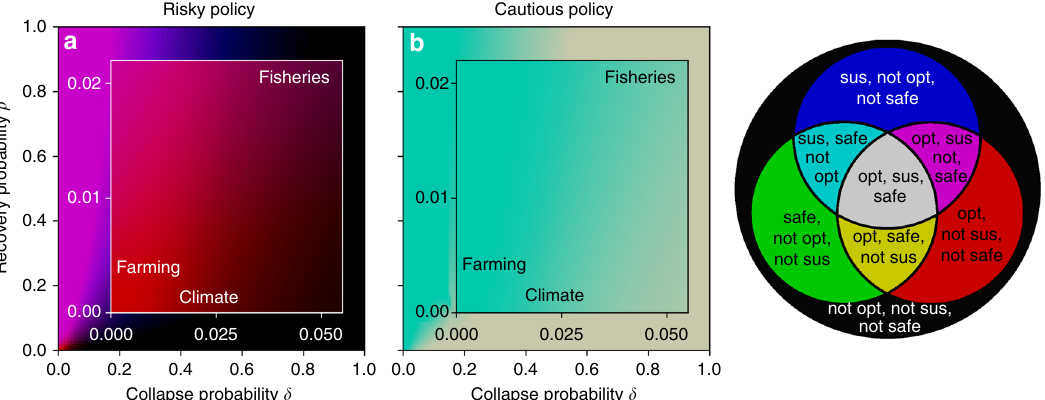
Fig. 5 Human-environment systems in paradigms classi fi cation. For risky ( a ) and ( b ) cautious policy here shown in model parameter space of collapse probability δ versus recovery probability ρ . Color indicates the paradigms combination similarly as in Fig. 3. Here, additional gradual changes between the color regimes indicate the probability of being in a certain paradigms combinations regime under parameter uncertainty ranges. Remaining parameters where chosen linearly within the range of 0.95 ≤ γ ≤ 0.99, 0.3 ≤ r l / r h ≤ 0.7, 0.1 ≤ r min / r h ≤ 0.5. The approx. transition probabilities δ and ρ were assigned to the human-environment systems climate, fi sheries and farming agriculture according to the timescale of the average time spent in one state (see Methods). For farming, a risky policy is likely to be optimal but neither sustainable nor safe. The parameter uncertainty of the other parameters does not allow a clear statement in which parameter regime fi sheries are likely to fall. The climate system may lie at the edge of the sweet spot, where all paradigms yield the cautious policy. However, for smaller collapse probability δ optimization is more likely to yield the risky policy, which becomes also neither sustainable nor safe at this point. This suggests the use of other paradigms for climate policy